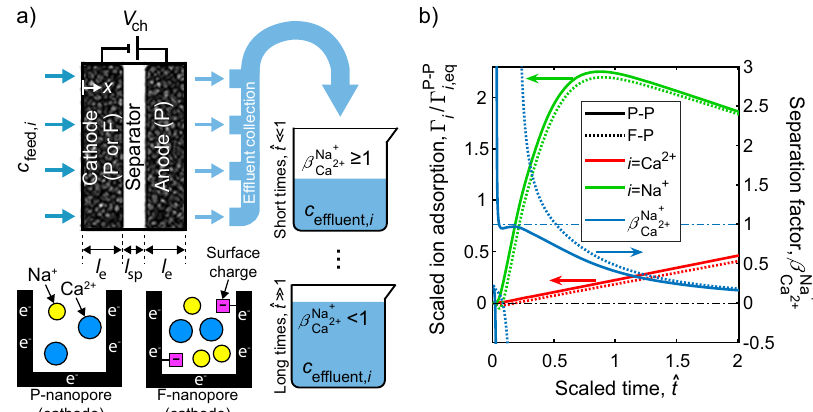
Fig. 2 CDI simulation design and predictions. a Schematic of the CDI system used in simulations with either pristine (P) or functionalized (F) cathodes, with electrode and separator thicknesses l e and l sp , respectively. Feedwater with ion concentrations c feed , i enters the cell at x = 0 while charging at V ch , and the resulting desalinated ef fl uent is collected for various scaled charging times, ^ t , to quantify Na + and Ca 2 + concentration, c ef fl uent,i , and separation factor, β Na þ . b Predictions of scaled Na + ion adsorption, Γ Na þ = Γ P (cid:1) P Ca 2 þ = Γ P (cid:1) P (left axis, red lines), and β Na þ (right axis, blue lines), as functions of ^ t . Calculations are for a model cell with either adsorption, Γ Ca 2 þ Ca 2 þ Ca 2 þ ; eq